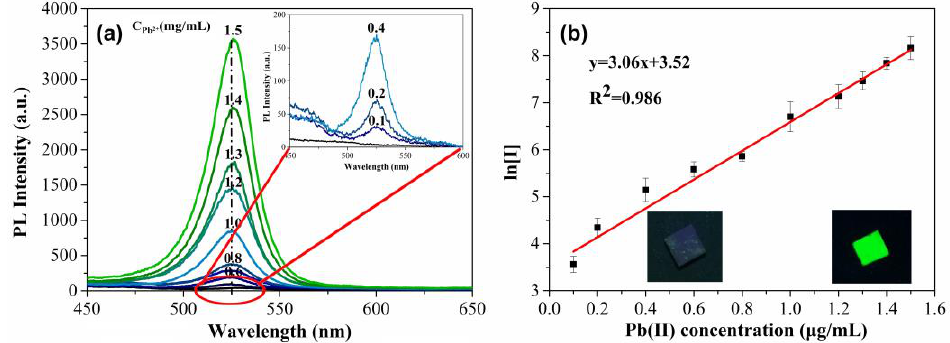
Figure 4. ( a ) PL spectra with different concentrations of Pb 2+ , ( b ) linear relationship between the ln[I] and Pb 2+ concentration. Insert photographs show the turn-on green PL along with the increase in Pb 2+ concentration under 365 nm UV excitation.